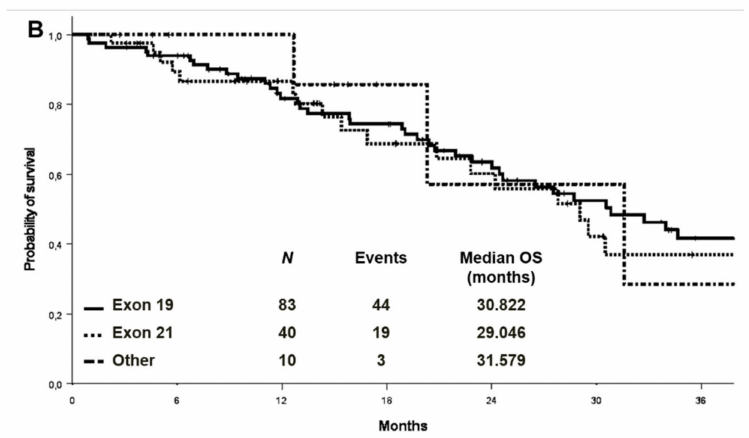
Figure 3. Progression-free survival ( A ) and overall survival ( B ) by EGFR mutation type in the entire cohort.